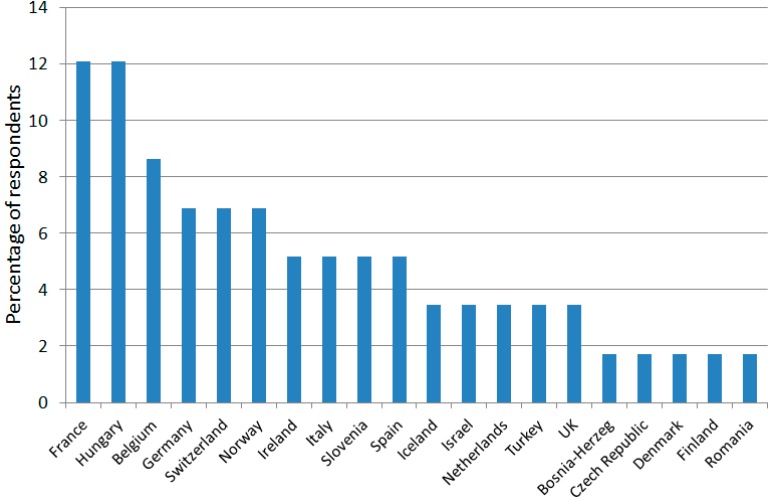
Figure 1. Percentage of survey respondents in different countries in Europe ( n = 58 respondents provided information about their country of origin, out of 68 total).